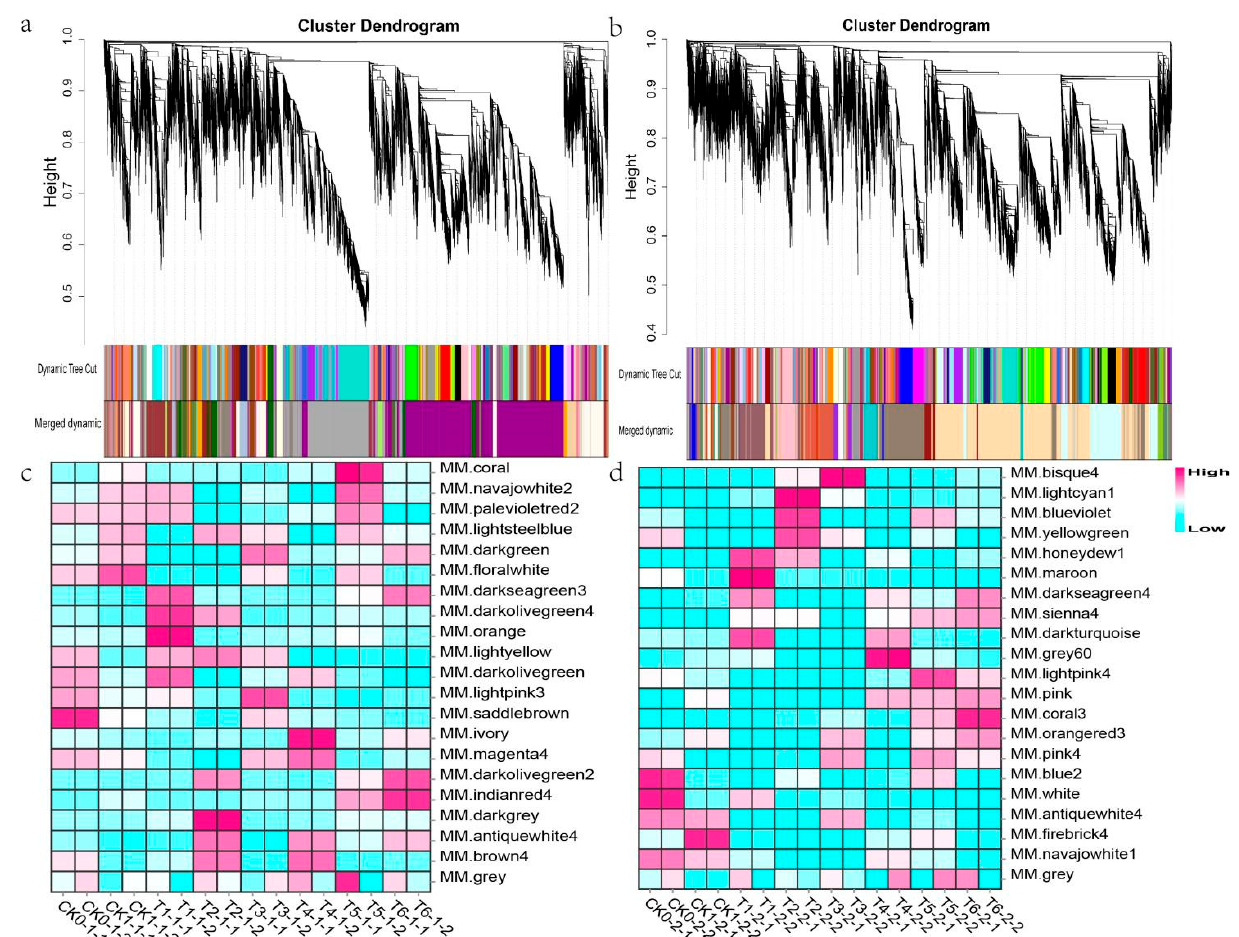
Figure 4. Identification of gene modules related to eggplant resistance to Ralstonia solanacearum infection. ( a , b ) Hierarchical cluster trees showing co-expression modules identified using WGCNA of the differentially expressed genes in the root ( a ) and stem ( b ). The grey module contained genes that could not be classified into any module. ( c , d ) Heatmaps showing module–sample expression pattern in the root ( c ) and stem ( d ). Magenta to cyan represents high to low expression.